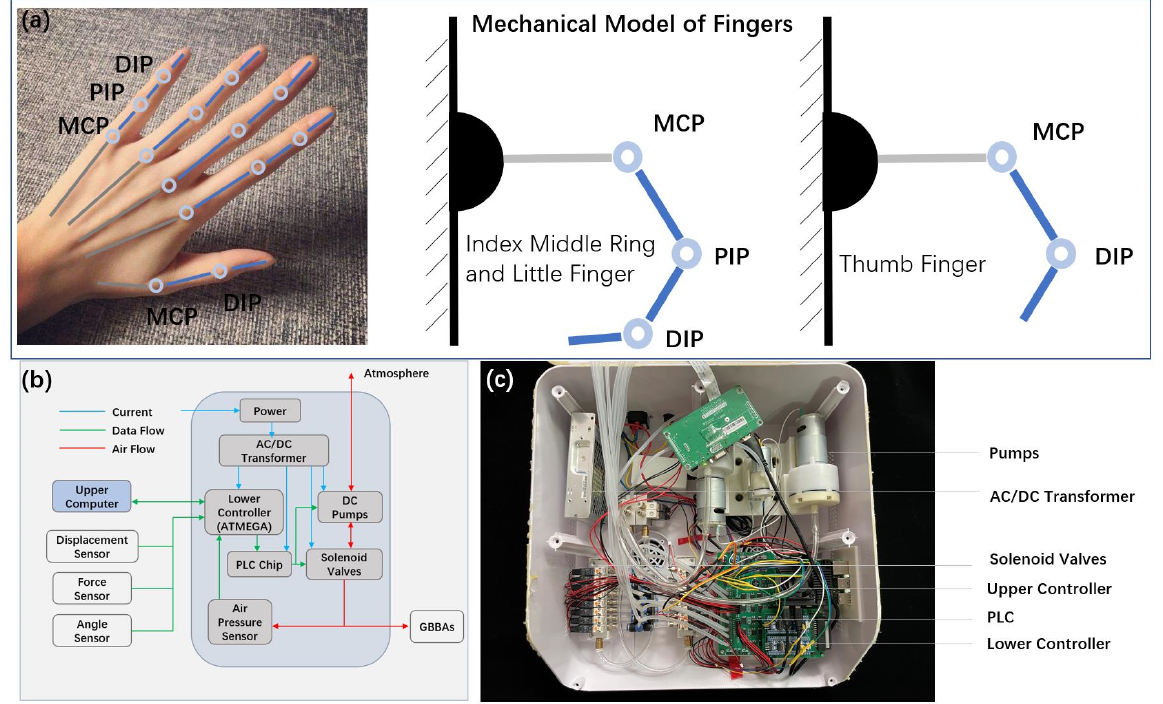
Figure 4. ( a ) Mechanical model of fingers rotation in one hand; ( b ) schematic diagram of control system which concludes current flow, data flow, and air flow; ( c ) physical diagram of the corresponding ten fingers control box.